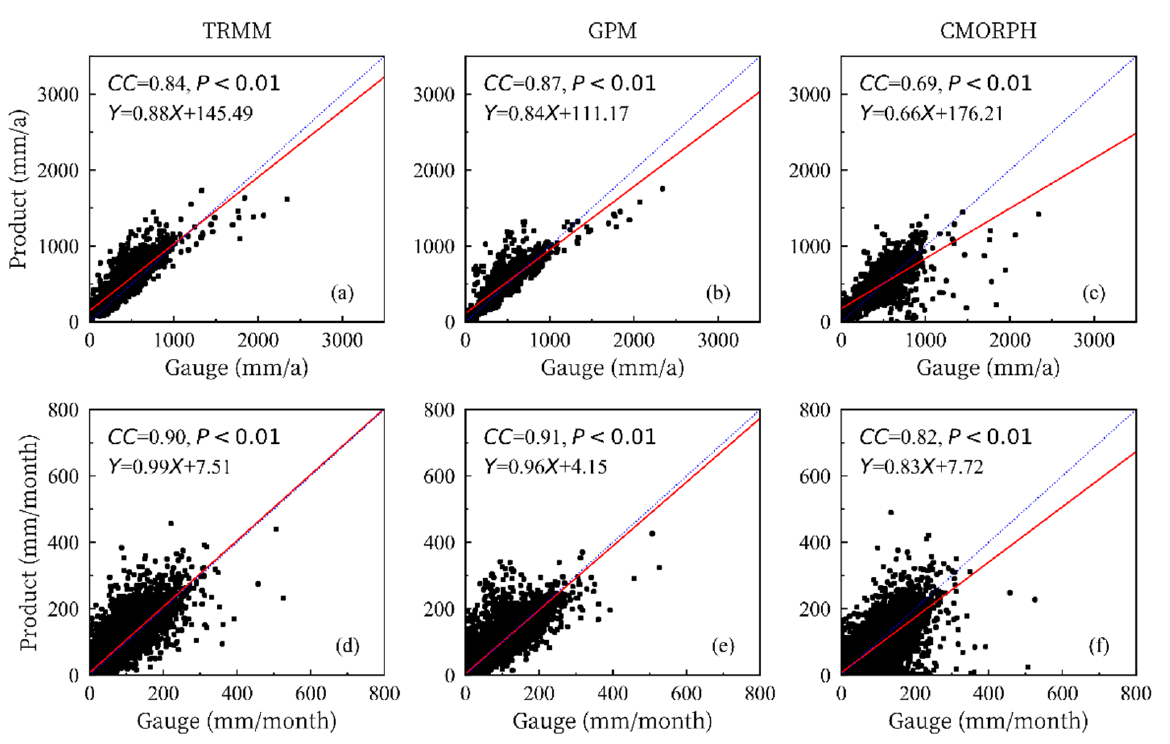
Figure 5. The scattered distribution between the three remote sensing precipitation products and gauge data at the ( a – c ) annual and ( d – f ) monthly scales during the study period. The red line and the blue dashed line represent the linear fitted line and the 1:1 line, respectively. If the p -value is less than 0.01, the linear correlation between the precipitation products and gauge measurement data is well fitted and passes the 99% confidence level test.